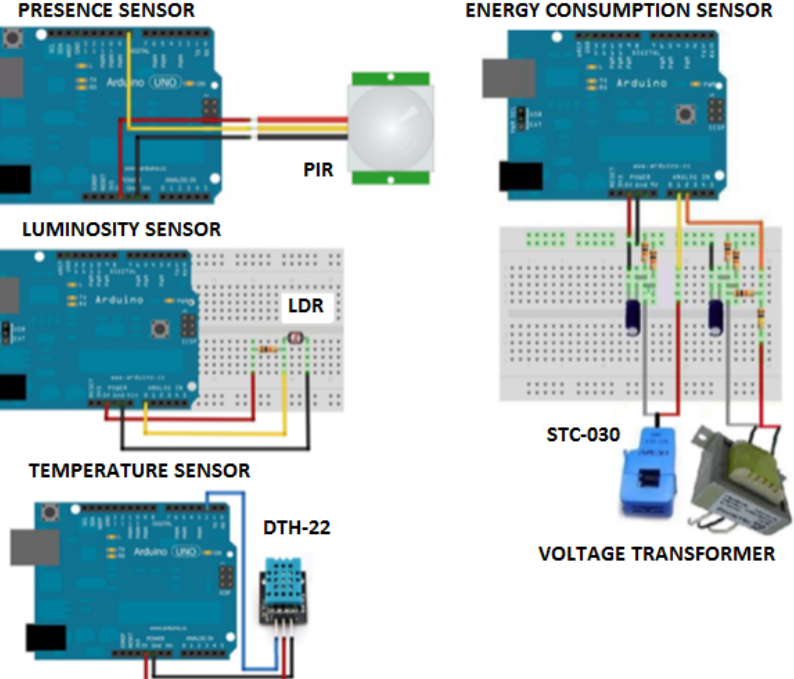
Figure 5. Assembly of each of the sensors to the Arduino.